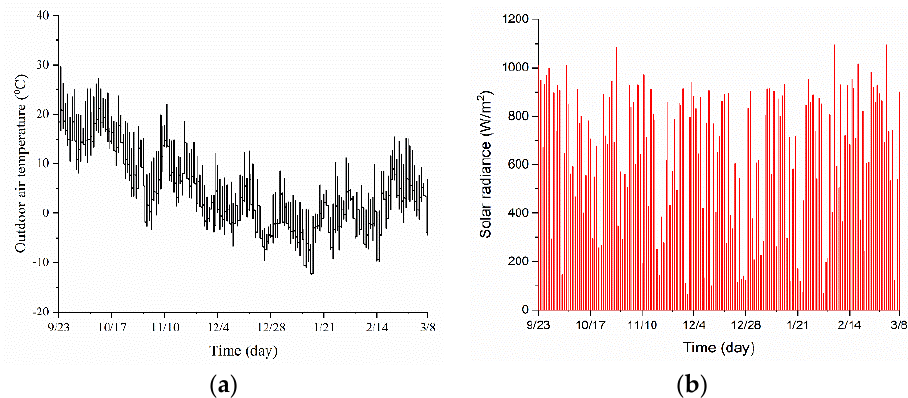
Figure 8. Weather conditions in Jinan during the experiment. ( a ) Outdoor air temperature and ( b ) Solar radiation.